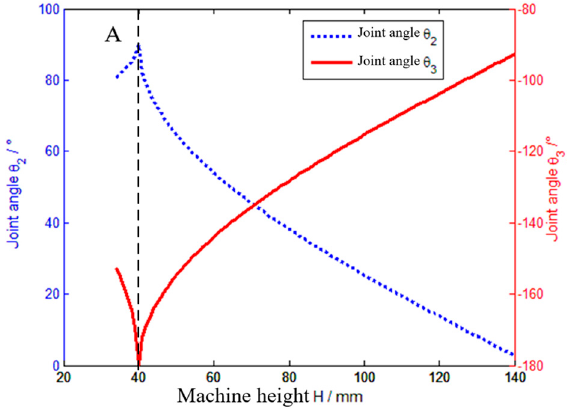
Figure 3. Joint angle of θ 2 and θ 3 when torque M is minimum under different center of gravity heights.